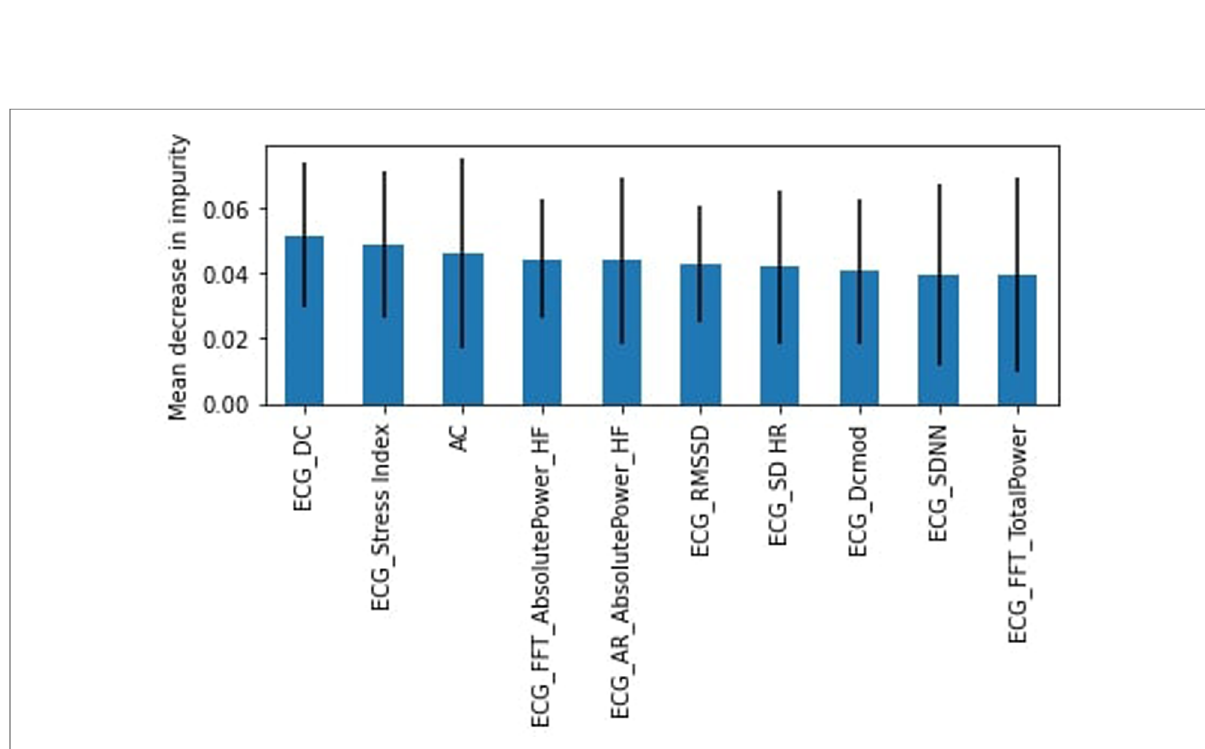
FIGURE 13 RF feature importance, Low SES